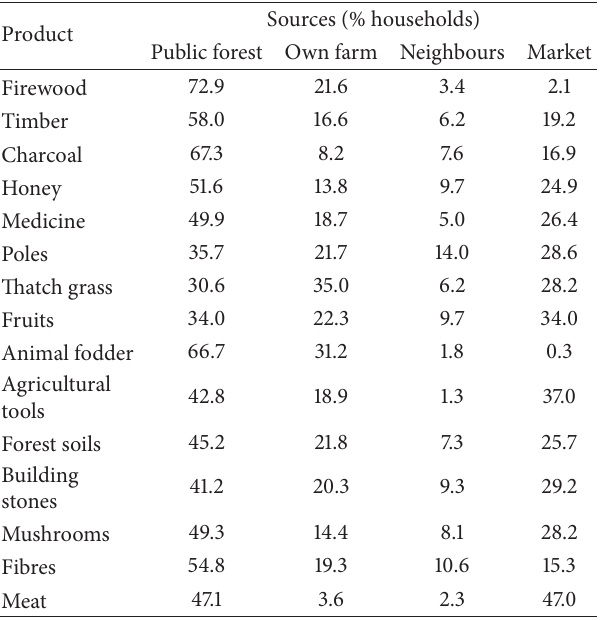
Table 2: Reported sources of forest products by of households ( 𝑁 = 367 ).